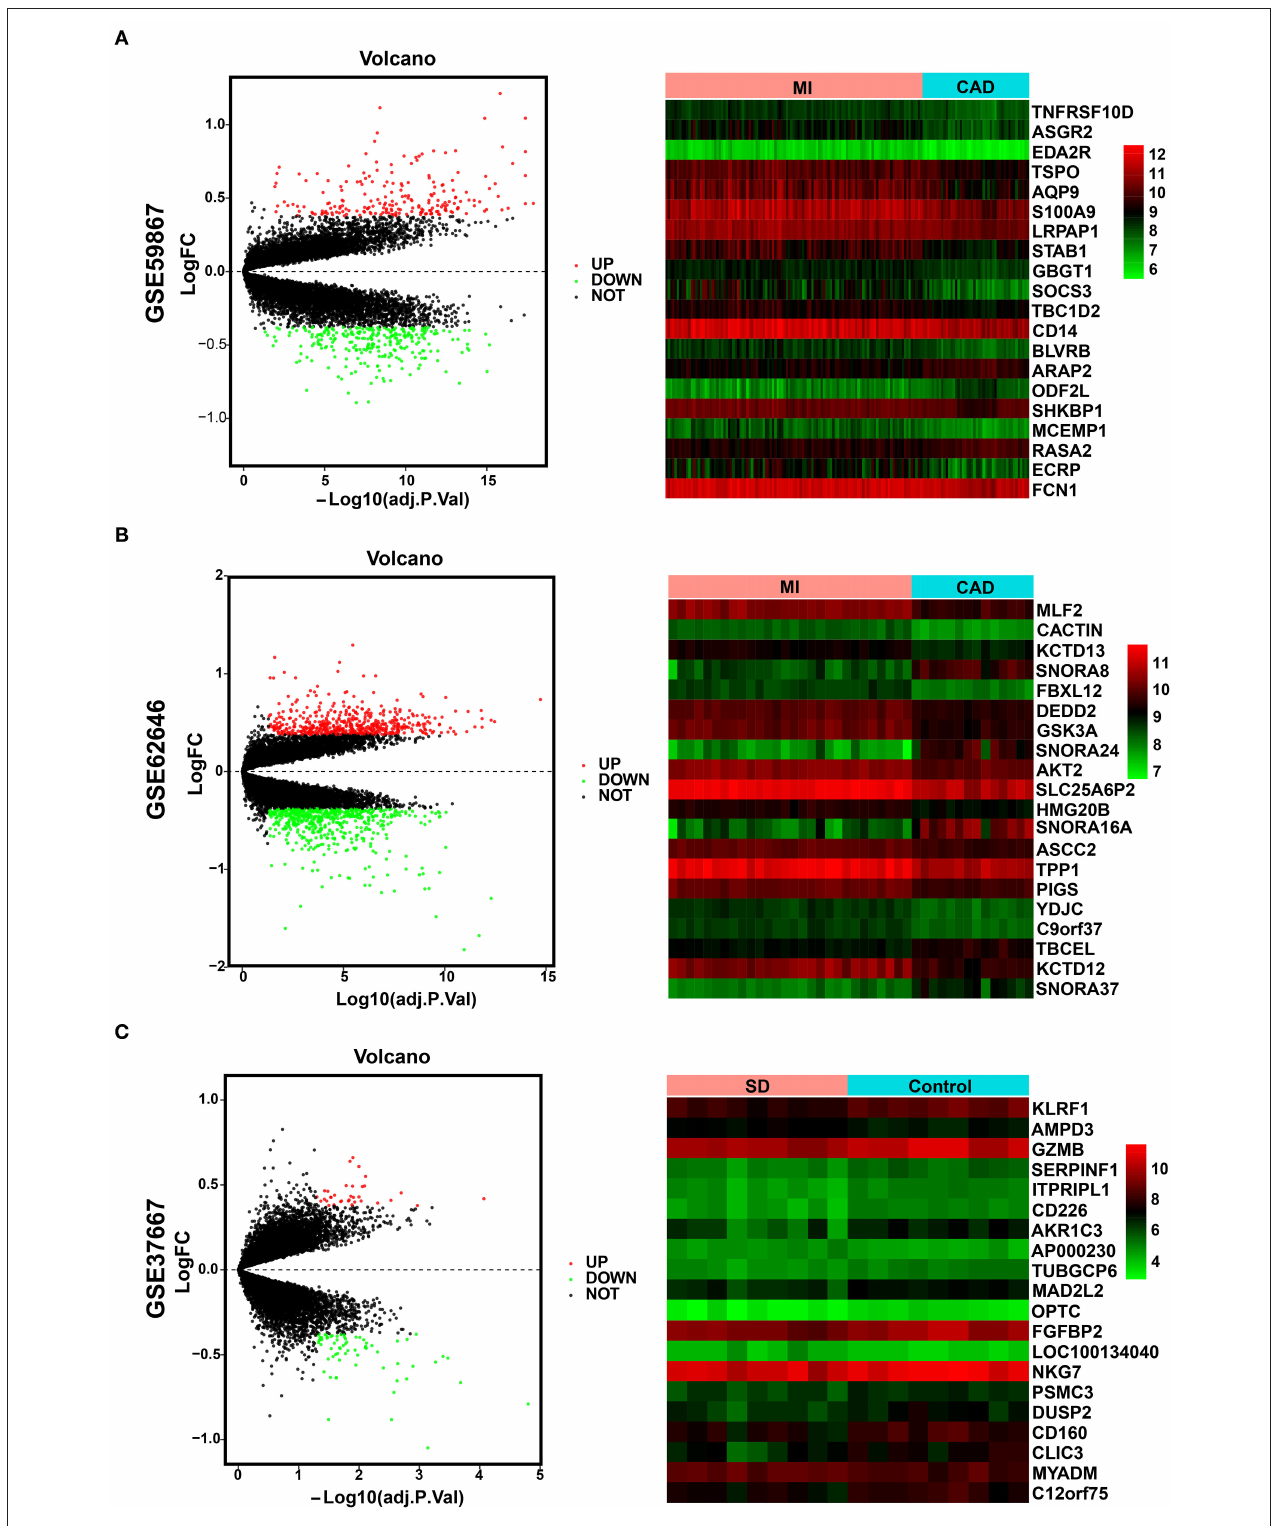
FIGURE 2 | Identification of MI-DEGs and SD-DEGs. (A) Volcano plot (left) and heatmap (right) of the GSE59867 dataset. In total, 491 MI-DEGs were identified from the GSE59867 dataset between the MI and CAD PBMC samples, including 282 downregulated and 209 upregulated genes. (B) Volcano plot (left) and heatmap